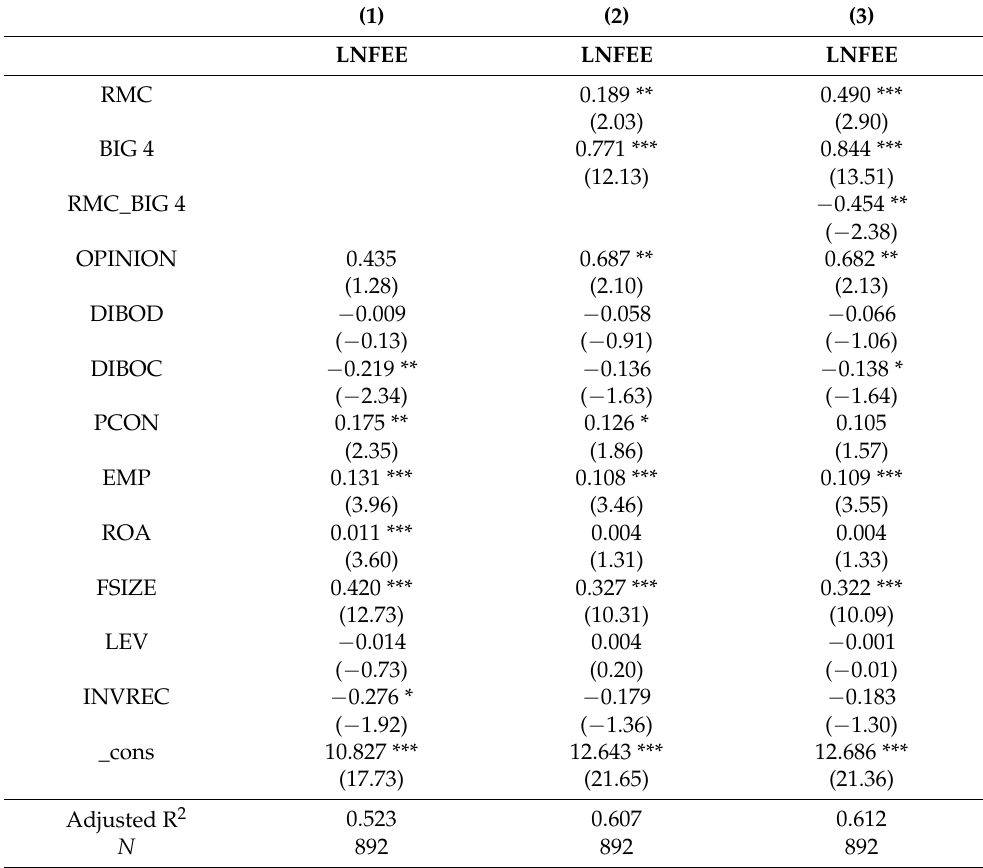
Table 6. Risk management committee, Big 4, and audit